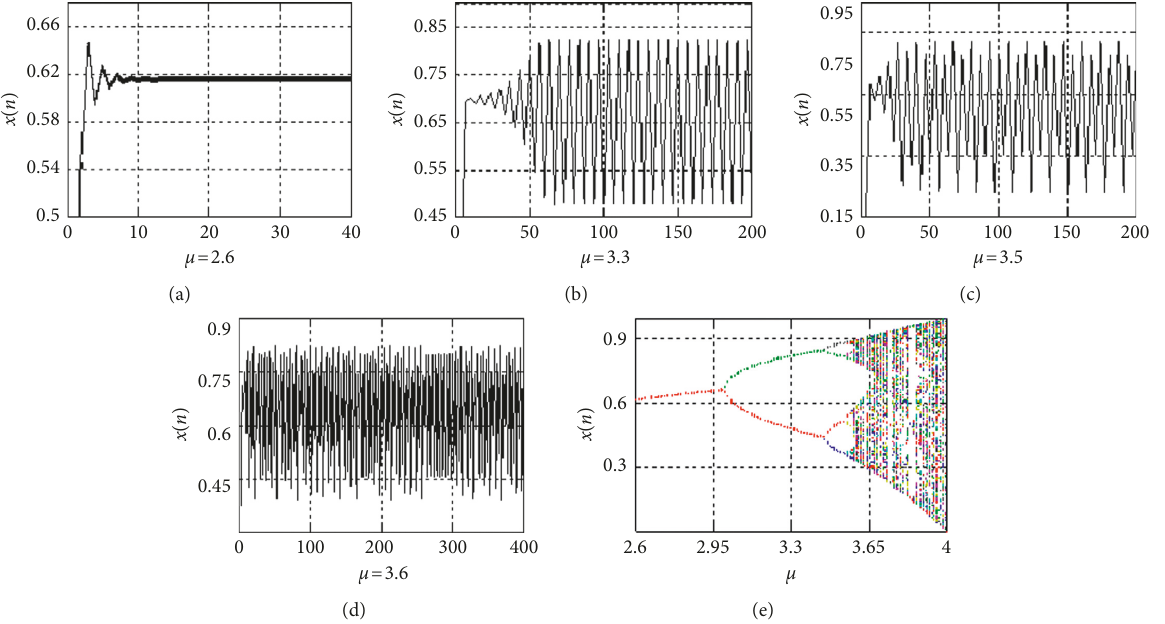
Figure 1: The chaotic dynamics of the logistic mapping. (a) 1